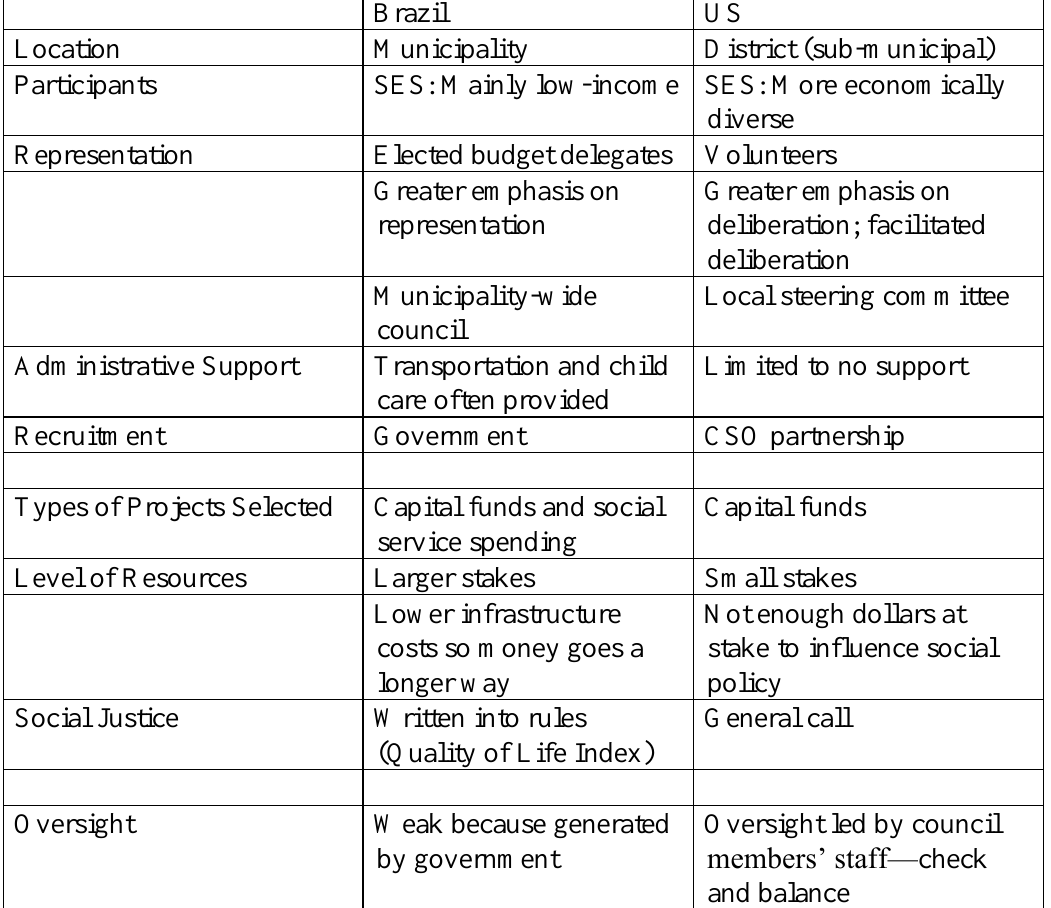
Table 2 Key Differences Between PB in Large Brazilian and US